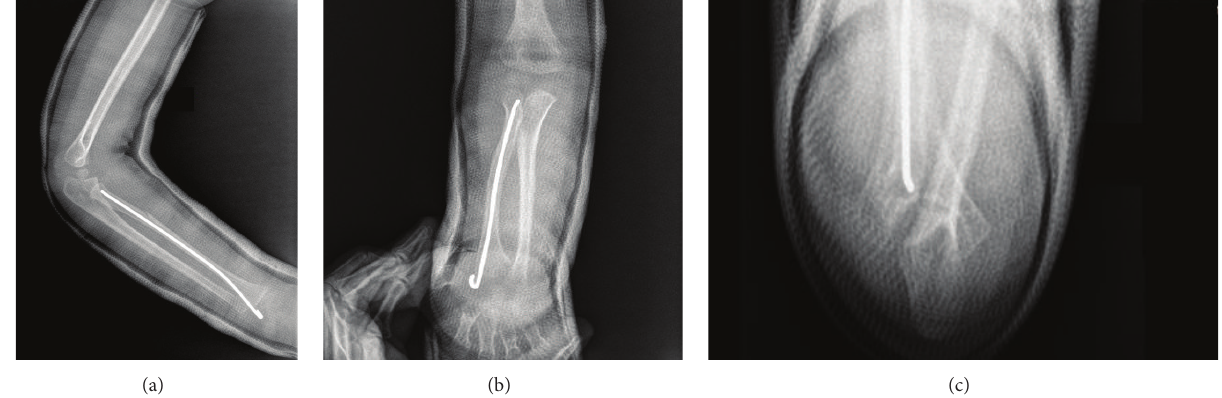
Figure 4: Postoperative radiographs show the radial head and anatomic ulnar reductions in lat (a), AP (b), and axial (c)